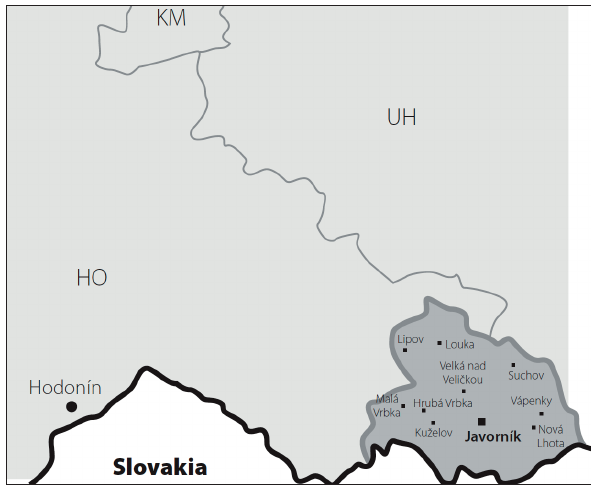
Fig. 1. Map of south-eastern Moravia with county borders. Dark gray area represents the region with its 10 villages, the village in which the large pedigree has been researched is high- lighted.